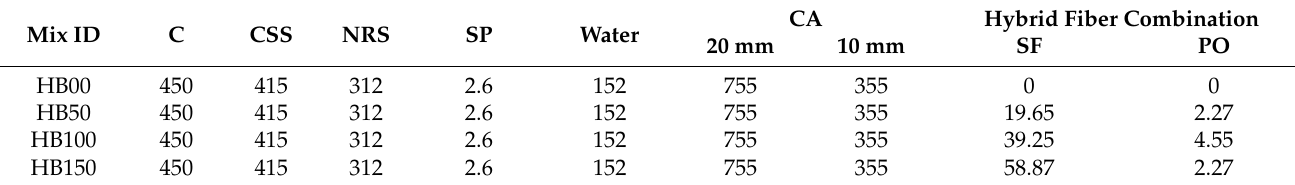
Table 2. Concrete mix design quantities in kg/m 3 .